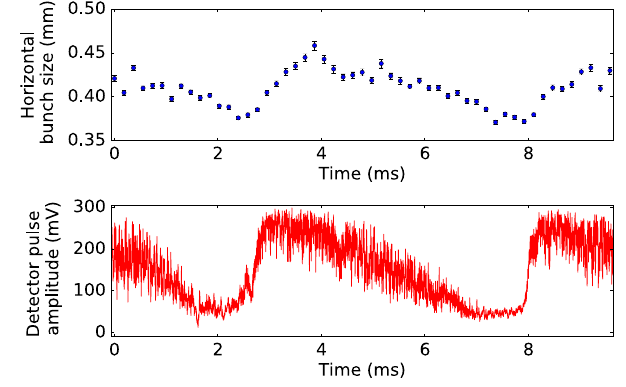
mA.FIG. 7. Horizontal bunch size as measure for the energy spread (top) and the synchronously measured CSR signal sampled using a Schottky diode (bottom). The energy spread shows the same modulation pattern as the CSR (raw data published in [[38], Fig. 10]). Beam parameter: f : 8.1 kHz, V : s RF 1500 kV, I : 0.88 bunch